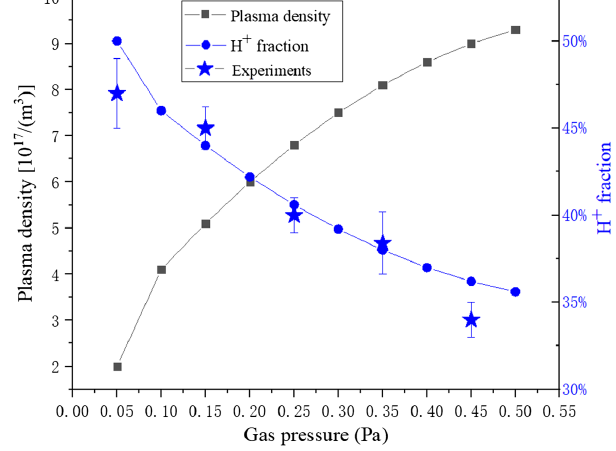
FIG. 9. Simulation and experimental results of plasma density and H þ fraction at different pressures (anode voltage is fixed at 1.5 kV and discharge gap fixed at 6 mm).